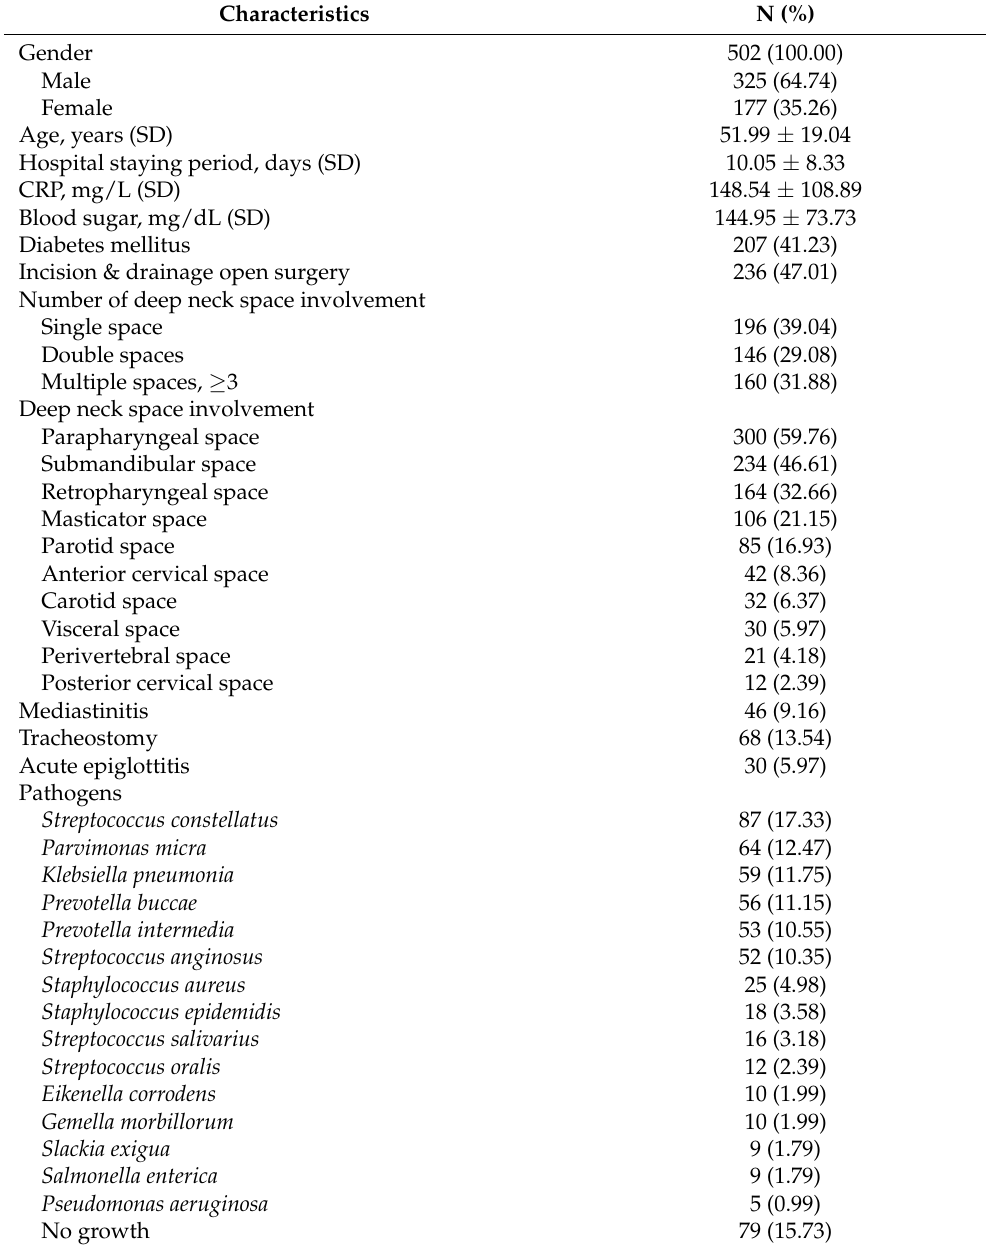
Table 1. Clinicopathological characteristics of the 502 patients with deep neck